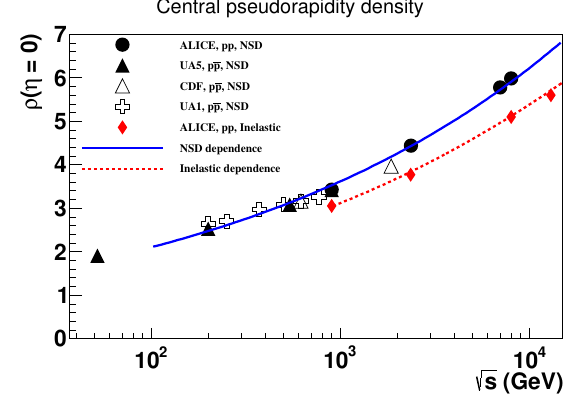
Figure 1. Non Single Di ff ractive data at scribed by four Gaussian functions. Green points represents re- sults from CMS experiment, blue are related to the TOTEM ex- periment.